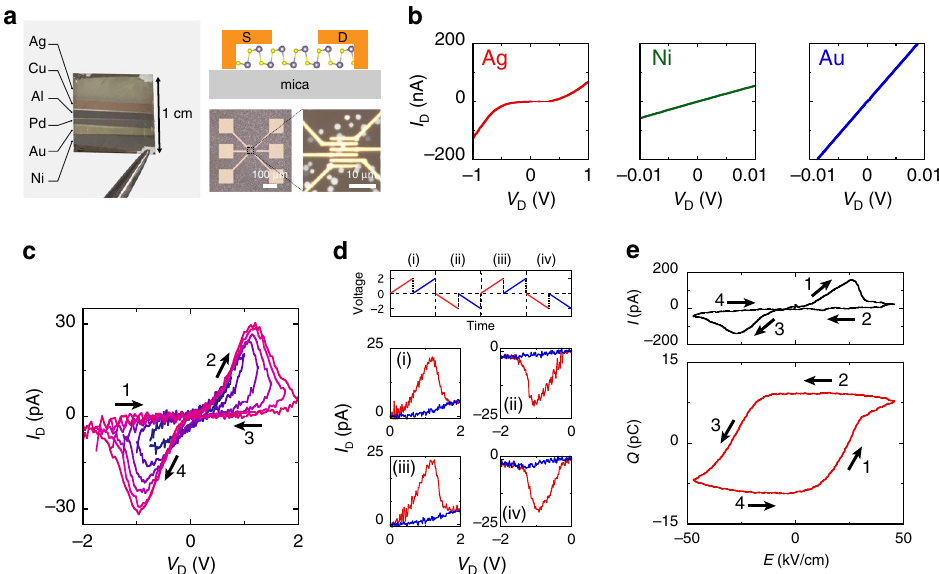
Fig. 4 Ferroelectric switching behaviors of few-layer SnS. a Left: Photograph of mica substrate after the deposition of various metals with different work functions. Right: Cross-sectional schematic and optical images of two-terminal SnS devices. Typical channel length l ch and width w ch were l ch = 0.4 – 0.8 µ m and w ch = 3 – 5 µ m, respectively. b I D – V D curves for bulk SnS with different metal contacts: Ag, Ni, and Au. c RT I D – V D for Ag/9L-SnS device with different V V − 1 → + 1 → − 1 V). d Double-wave measurement from 0 to 2 and 0 to − 2 V. Top: D sweep ranges. D was swept from minus to plus to minus (e.g., applied voltage along time. The voltage was applied two times at the positive and negative bias repeatedly. Bottom: I D – V D curves for different sweeps (i) – (iv). The red and blue lines represent the fi rst and second sweep, respectively. e Ferroelectric resistive switching for Ag/SnS: current and charge versus nominal electric fi eld measured by ferroelectric measurement system at 1 Hz and